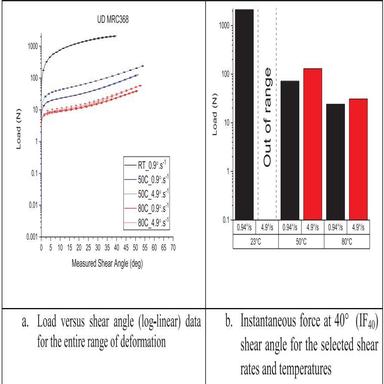
BE test results of CEP-UD at different temperatures and shear rates.